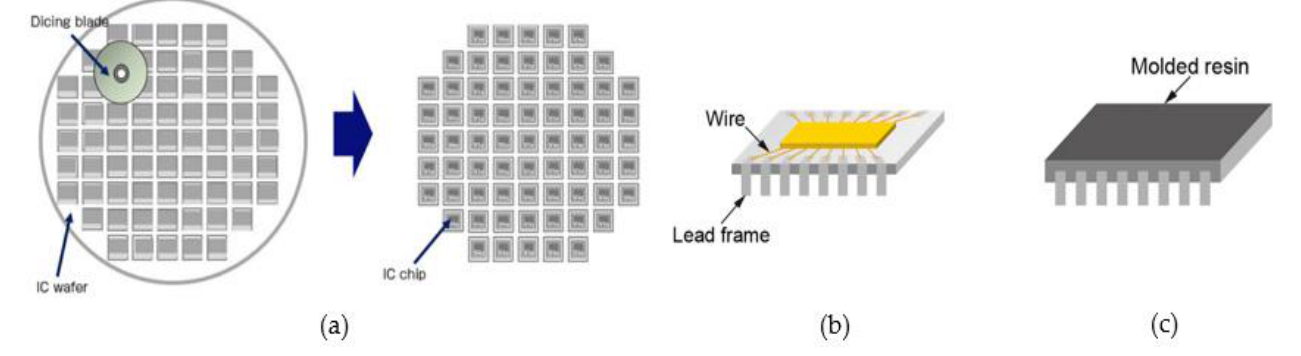
Figure 20. Back-end process: ( a ) dicing; ( b ) die bonding; and ( c ) molding [80,81].